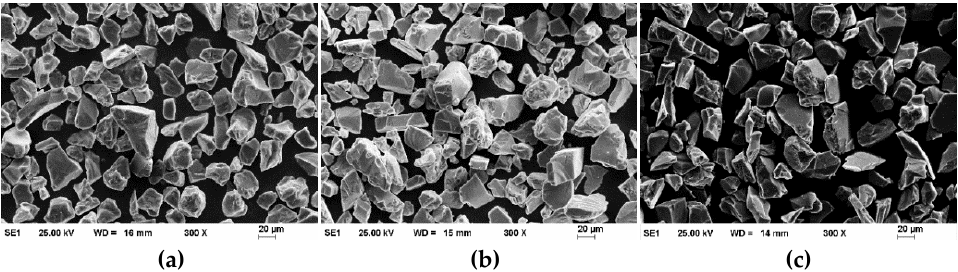
Figure 1. SEM images of the feedstock powders. ( a ) Al 2 O 3 . ( b ) Cr 2 O 3 . ( c ) TiO x .